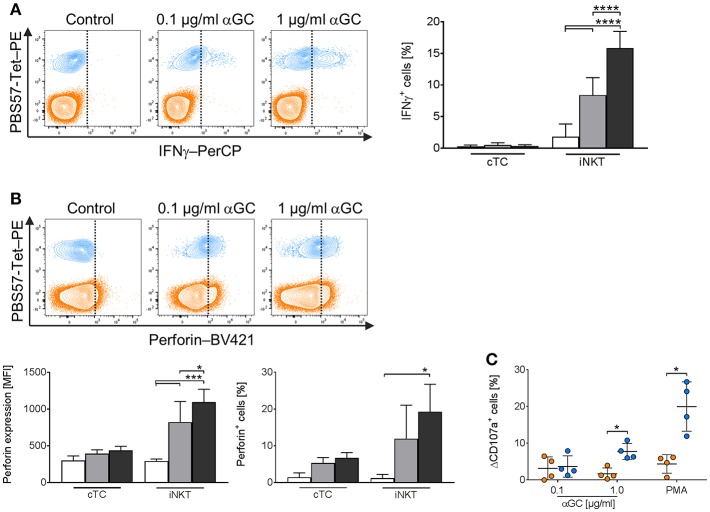
Expression of IFNγ and perforin and degranulation of activated porcine iNKT cells upon antigenic activation. Porcine PBMC were cultivated in the presence of 0.1 μg/ml (gray) or 1 μg/ml αGC (black) or DMSO (white) as a control for 4 days. At day 4, the cells were restimulated with medium containing the respective treatment. 2 h later, Brefeldin A was added and the cells were incubated for another 4 h. Intracellular expression of IFNg and perforin in iNKT cells (blue) and cTC (orange) was analyzed by flow cytometry. (A) Representative flow cytometric plots showing IFNγ expression in iNKT cells and cTC (vertical line indicates threshold based on expression level in controls). Frequency of IFNγ-expressing iNKT cells and cTC in controls and after stimulation with 0.1 μg/ml or 1 μg/ml αGC (n = 5-7). (B) Representative flow cytometric plots showing perforin expression (vertical line indicates threshold based on expression level in controls). Expression level of perforin in iNKT cells and cTC in controls and after antigenic stimulation. Perforin+ iNKT cells and cTC after antigenic stimulation (n = 4). (C) CD107a surface expression on iNKT cells and cTC after stimulation with 0.1 μg/ml or 1 μg/ml αGC and PMA/ionomycin. Specific degranulation was calculated as the difference in surface expression of stimulated and control cells and is given as ΔCD107a (n = 4). Data shown as mean (SD), *p < 0.05, ***p < 0.001, ****p < 0.0001, repeated-measures one-way ANOVA with Holm-Sidak's post-hoc test for multiple comparisons.